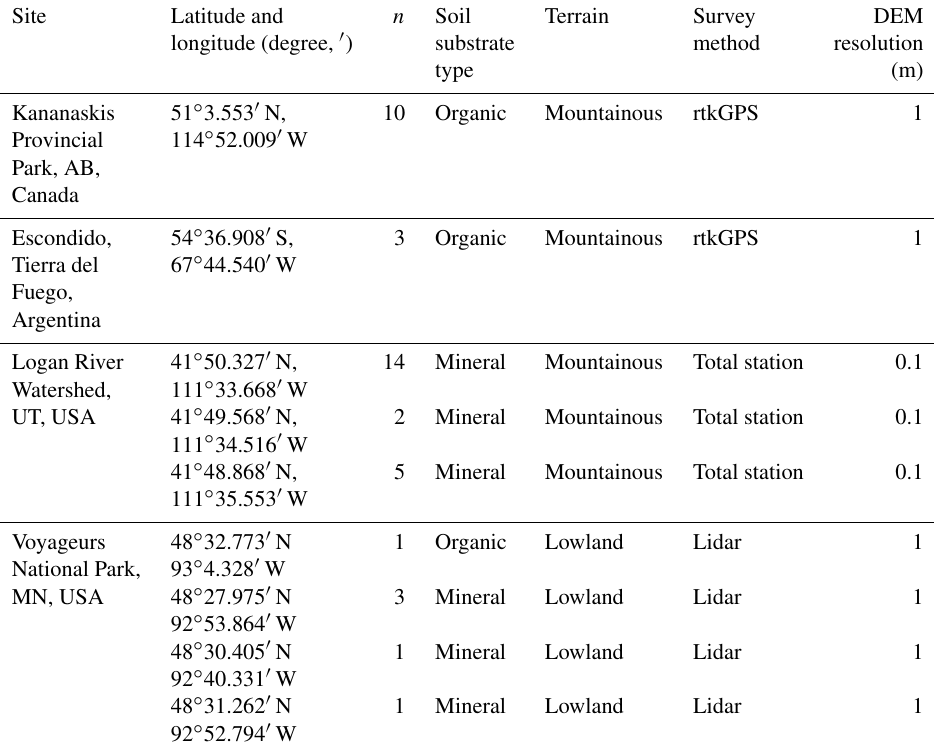
Table 1. Site locations, characteristics, and details of topographic pond surveys. “ n ” is the number of ponds studied at each site. Site Latitude and n Soil Terrain Survey DEM longitude (degree, (cid:48) ) substrate method resolution type (m) Kananaskis 51 ◦ 3.553 (cid:48) N, 10 Organic Mountainous rtkGPS